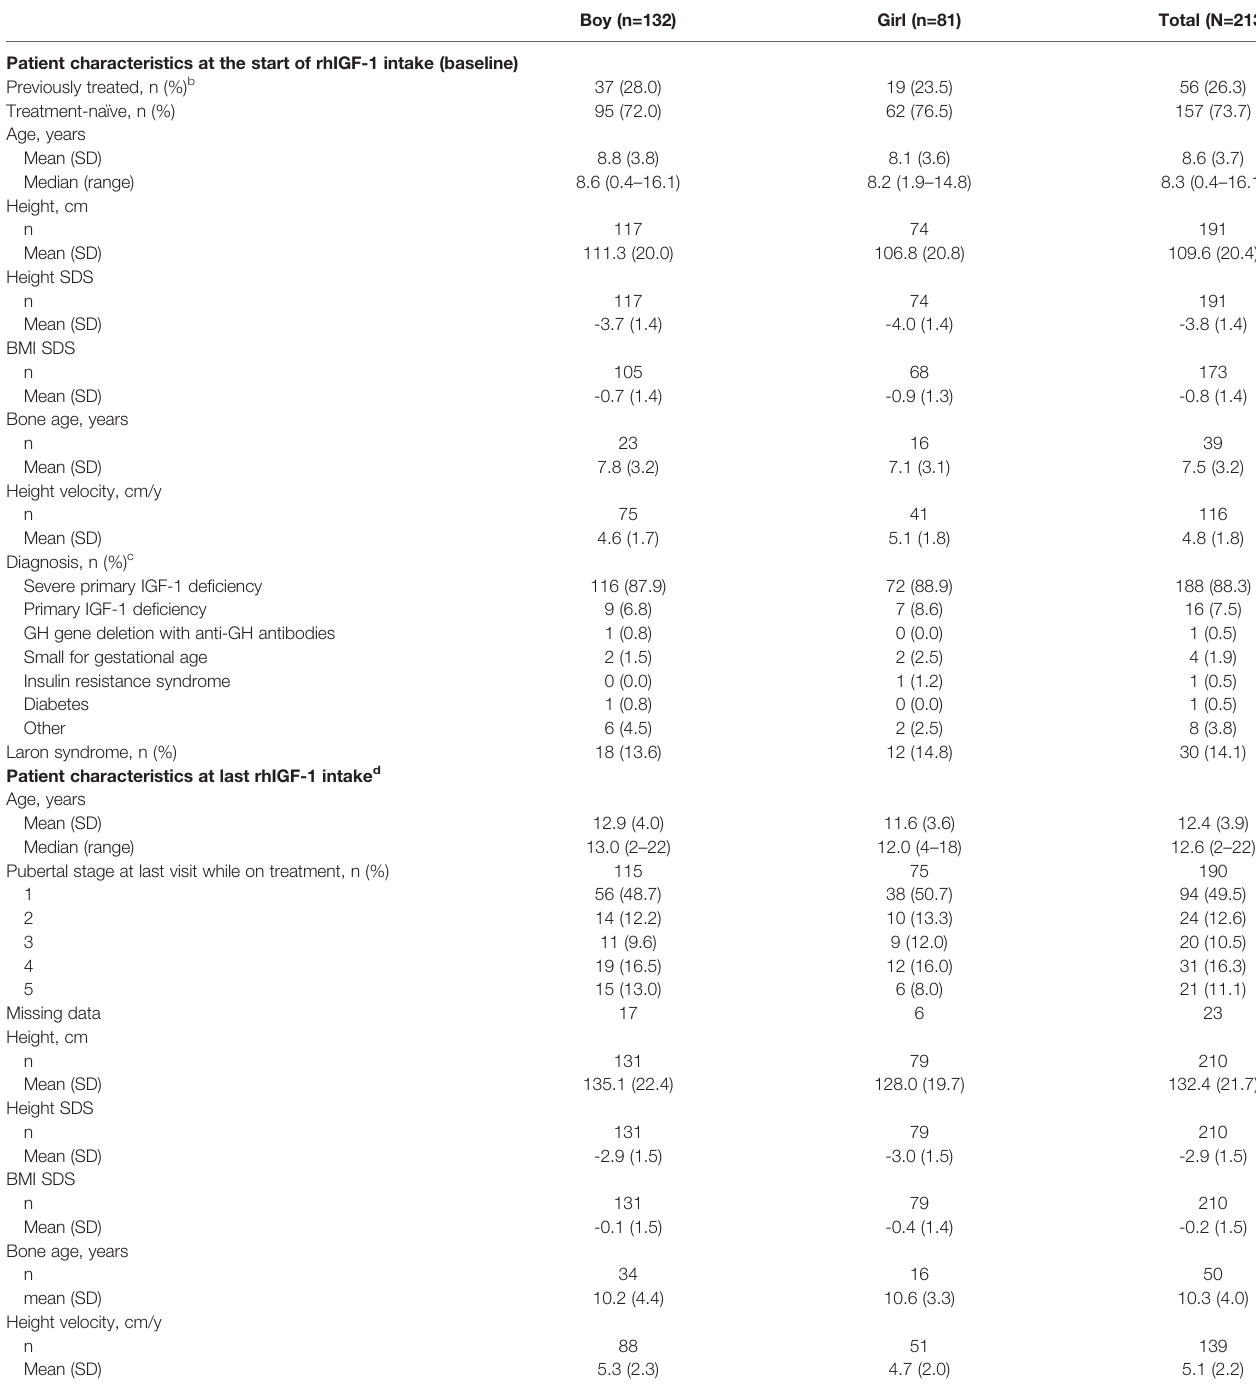
TABLE 1 | Patient characteristics of prepubertal a patients at the start of rhIGF-1 intake in the Eu-IGFD Registry (baseline) and at last rhIGF-1 intake. Boy